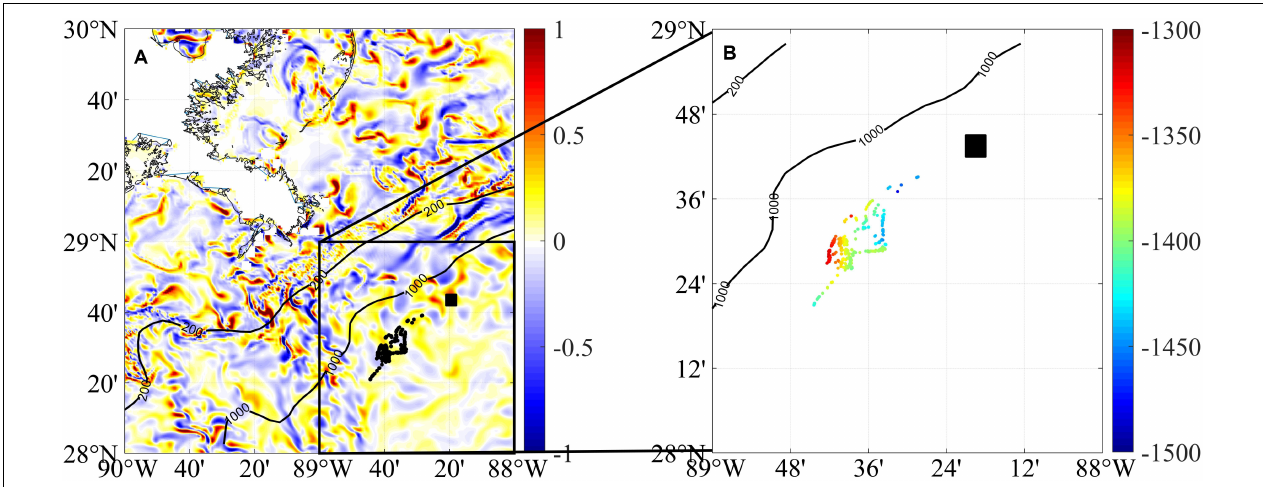
FIGURE 4 | Physical-only modeling of advection around the DWH site. (A) Distribution of buoyancy neutral particles freely advected in three-dimensional space 1 month after their release at the Deepwater Horizon site. The particles are rendered in black and were released within the black box, then drifted to the southwest. The particle’s position is superimposed upon a map of the near-bottom vorticity field ( ζ /f, estimated at the time of release). The particle dispersion at this 1-month time occurs following bathymetric and vorticity structures. (B) Zoom around the location of the particles with their depth indicated by color (Unit: m). Figure modified from Bracco et al.